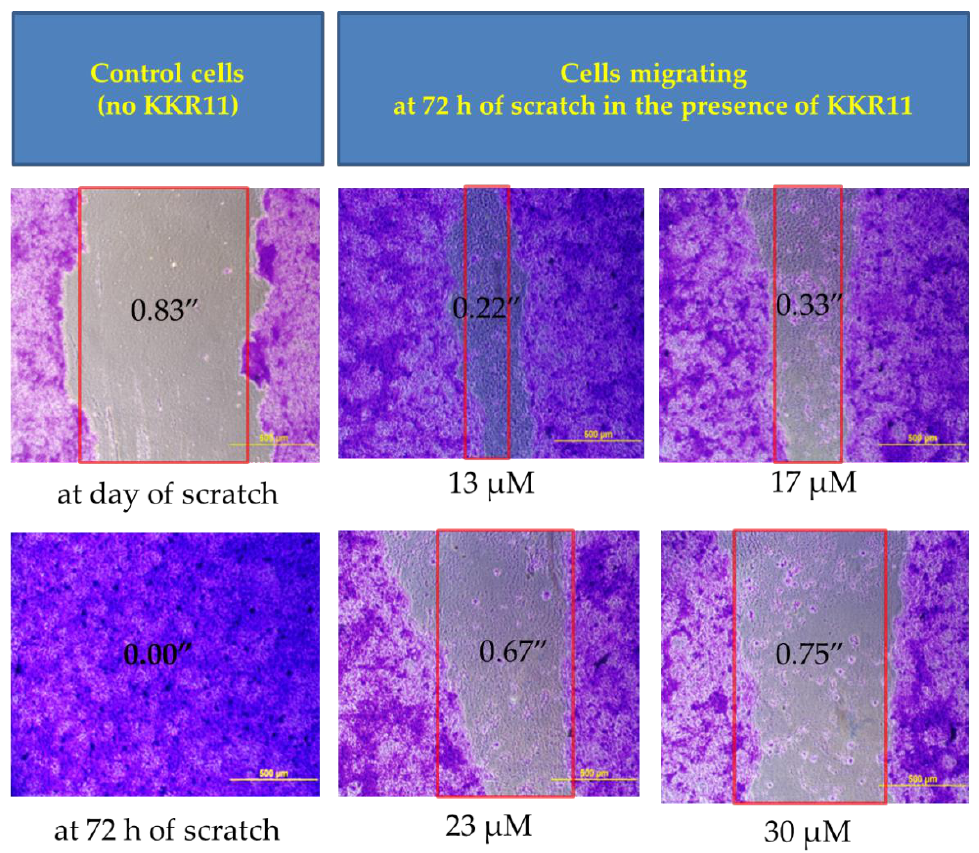
Figure 9. Migration of metastatic PCa cells in the presence of KKR11. The treated cells lost their ability to migrate to the space gap. DU145 cells of similar densities and incubation time were subject to scratch assay for mimicking cell migration. Scratches of original widths were fixed at the beginning of the assay. Treated cells were incubated for 72 h until the counterpart controls gaps are closed ( n = 3). All tested cells were fixed, stained, and imaged (phase contrast, 10X). The scratch widths were analyzed. The red lines represent the approximate cell front.